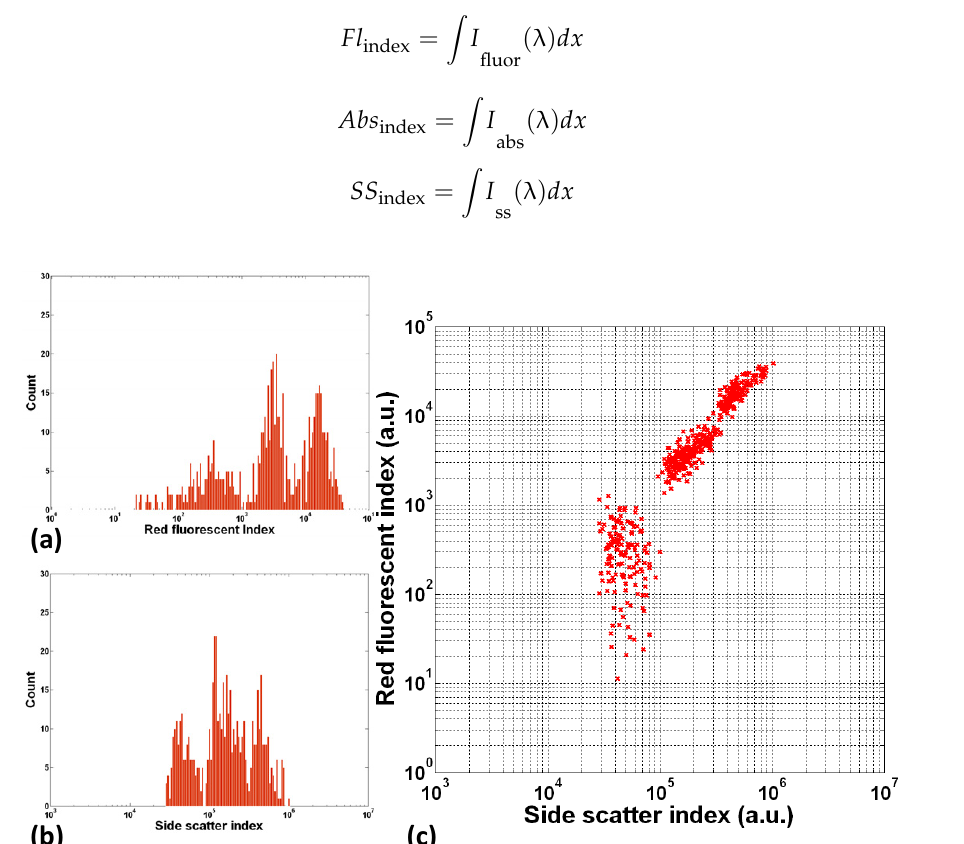
Figure 5. Flow cytometer detection results for mixed sample composed of particles with sizes of 3, 10 and 15 µ m, respectively: ( a ) one-dimensional histogram for fluorescence emission, ( b ) one-dimensional histogram for side scatter, ( c ) scatter plot of fluorescent index and side-scatter index.